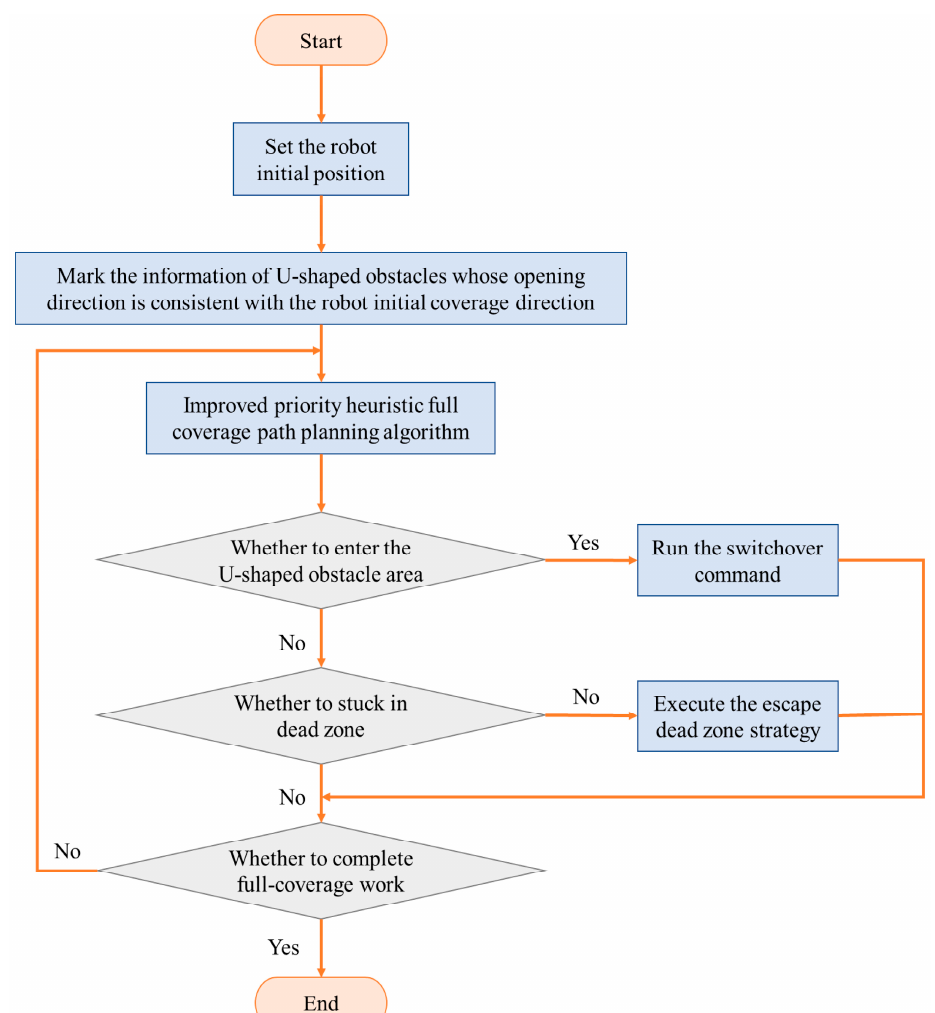
Figure 11. Improved priority heuristic algorithm.